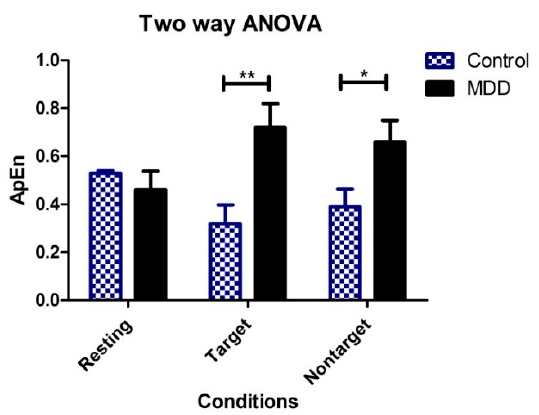
Figure 7. Two-way ANOVA showing group means of ApEn for each of the three conditions (vertical bars represent SD). ** p < 0.01, * p < bars represent SD). ** p < 0.01, * p < 0.05.